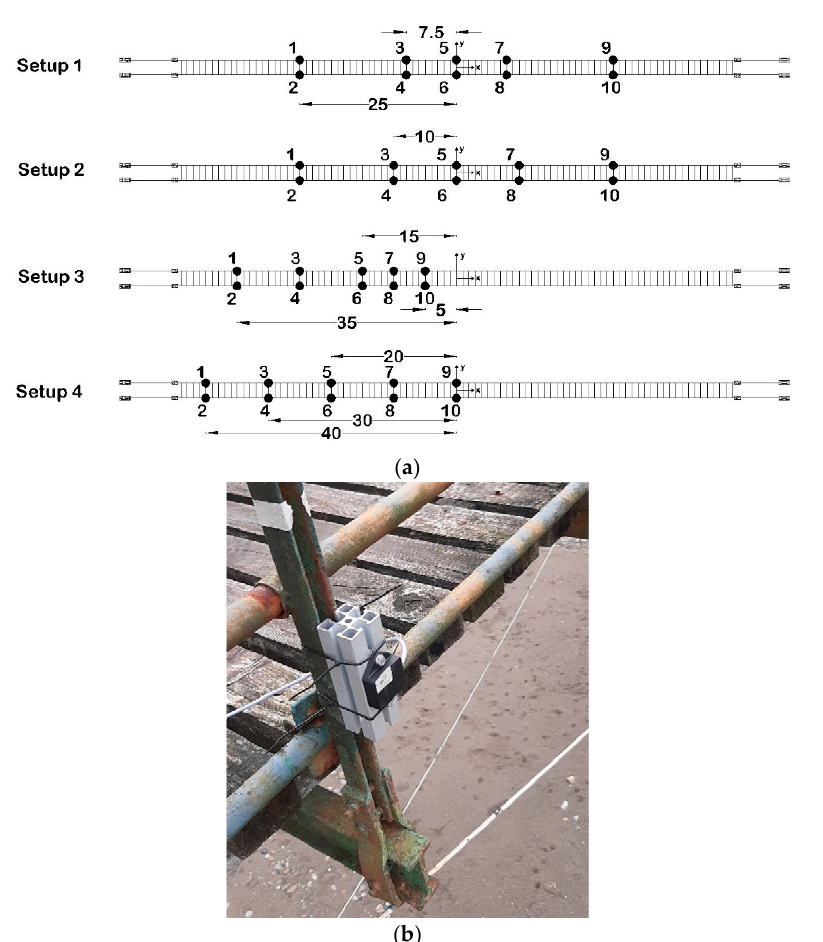
Figure 6. Layout and location of accelerometers along the bridge deck for different measurement setups (in m) ( a ) and detail of the accelerometers’ mounting ( b